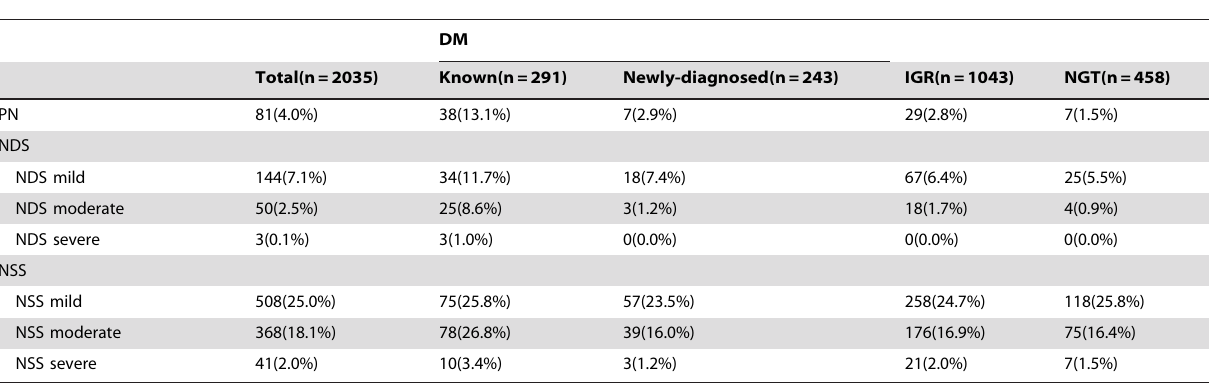
Table 3. The prevalence of PN in diabetes and impaired glucose regulation.